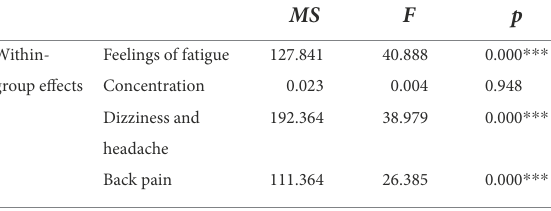
TABLE 10 Repeated measures ANOVA of fatigue perception, concentration, dizziness and headache, and back pain of participants in the intervention group before and after the